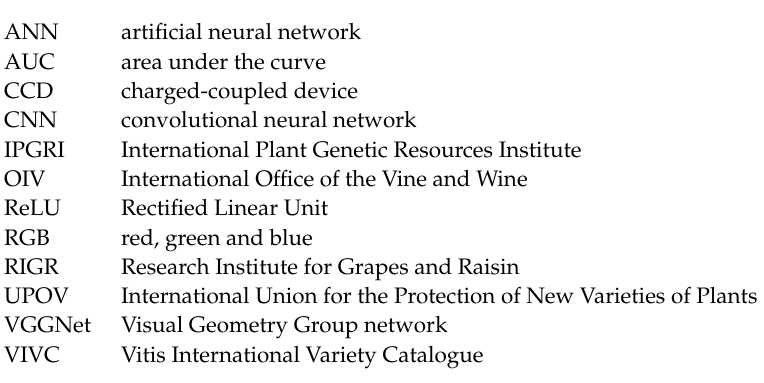
Table S1: Camera specifications employed in this